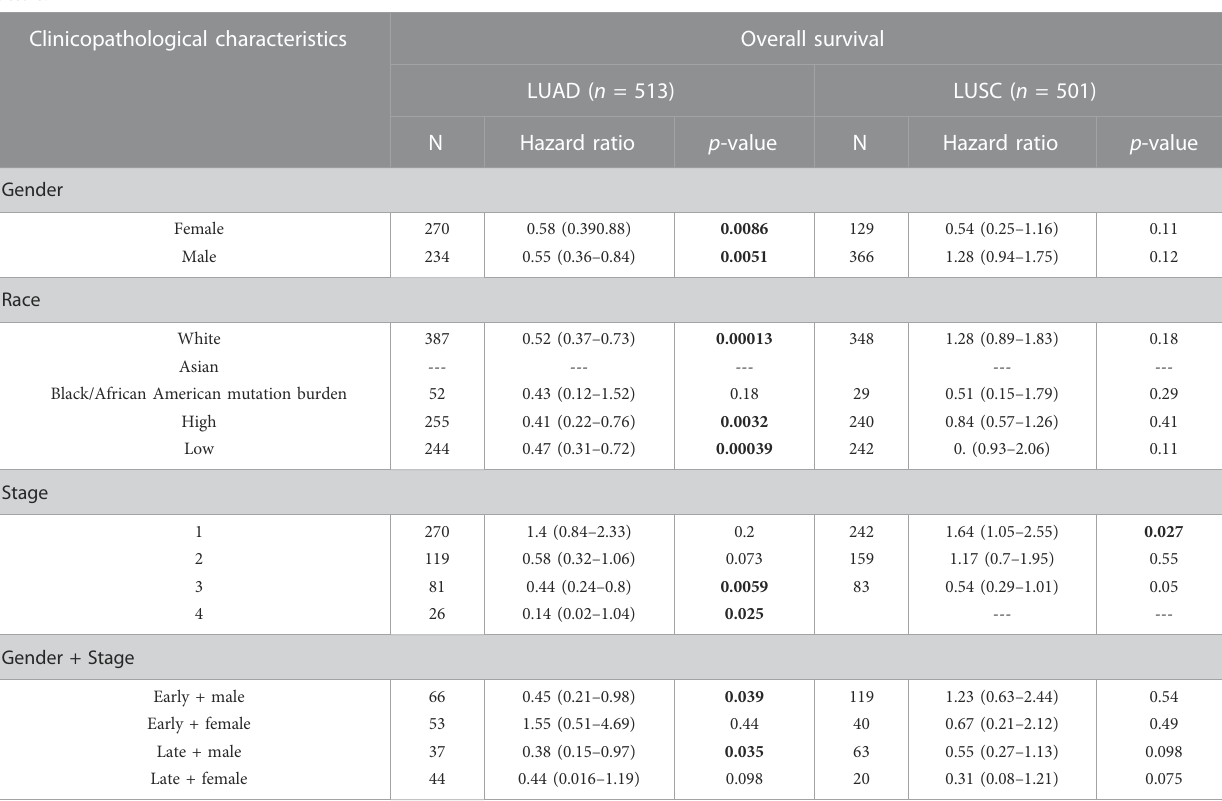
TABLE 1Correlationof the mRNA expression level of TMPRSS2indifferentstage andclinicalprognostic potential inlung cancer with different clinicopathological factors. Clinicopathological